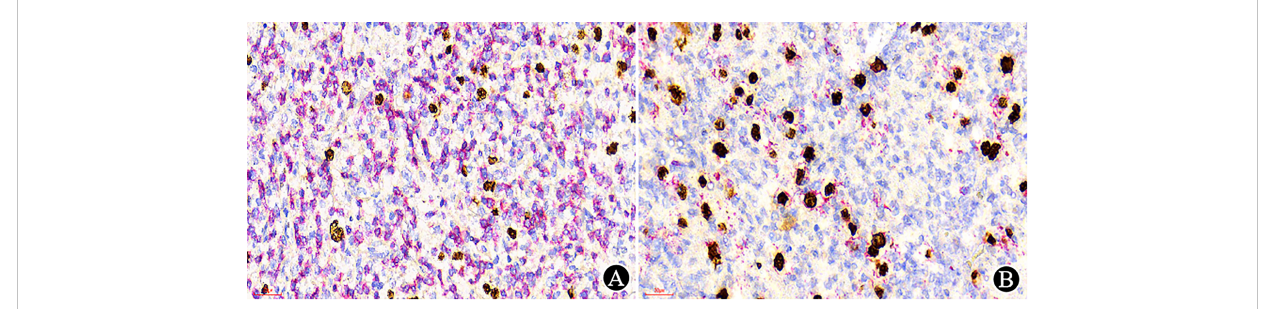
FIGURE 5 Dual-staining with EBER (nuclear stain in brown) and CD3/CD20 (membranous and cytoplasmic in red) (×400). (A) EBER/CD3 dual-staining showed no dual-staining positive cells; (B) EBER/CD20 dual-staining demonstrated dual-positive